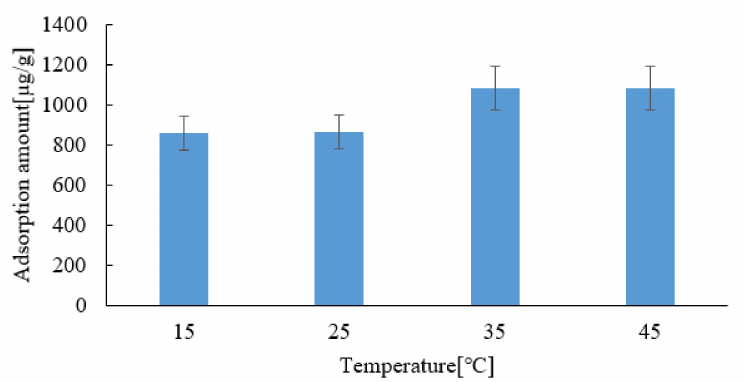
Figure 18. E ff ect of temperature on the adsorption of Cr(VI) on the SDS-modified chitosan beads.